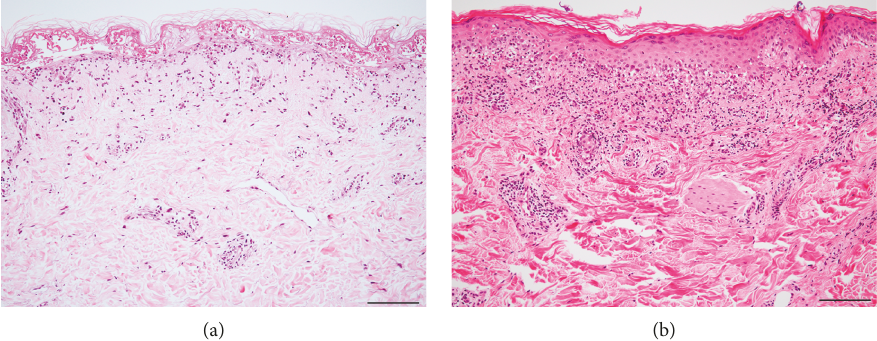
Figure 1: Hematoxylin-eosin (HE) sections of toxic epidermal necrolysis (TEN) (a) and erythema multiforme (EM) (b). (a) Subepidermal bullae under full-thickness epidermal necrosis. Note: the cell-poor dermal in fl ammation. (b) An interface reaction pattern with in fi ltrates of lymphocytes and scattered necrotic keratinocytes. Lymphocyte in fi ltrates are much denser in EM than in TEN. Bar=100 μ